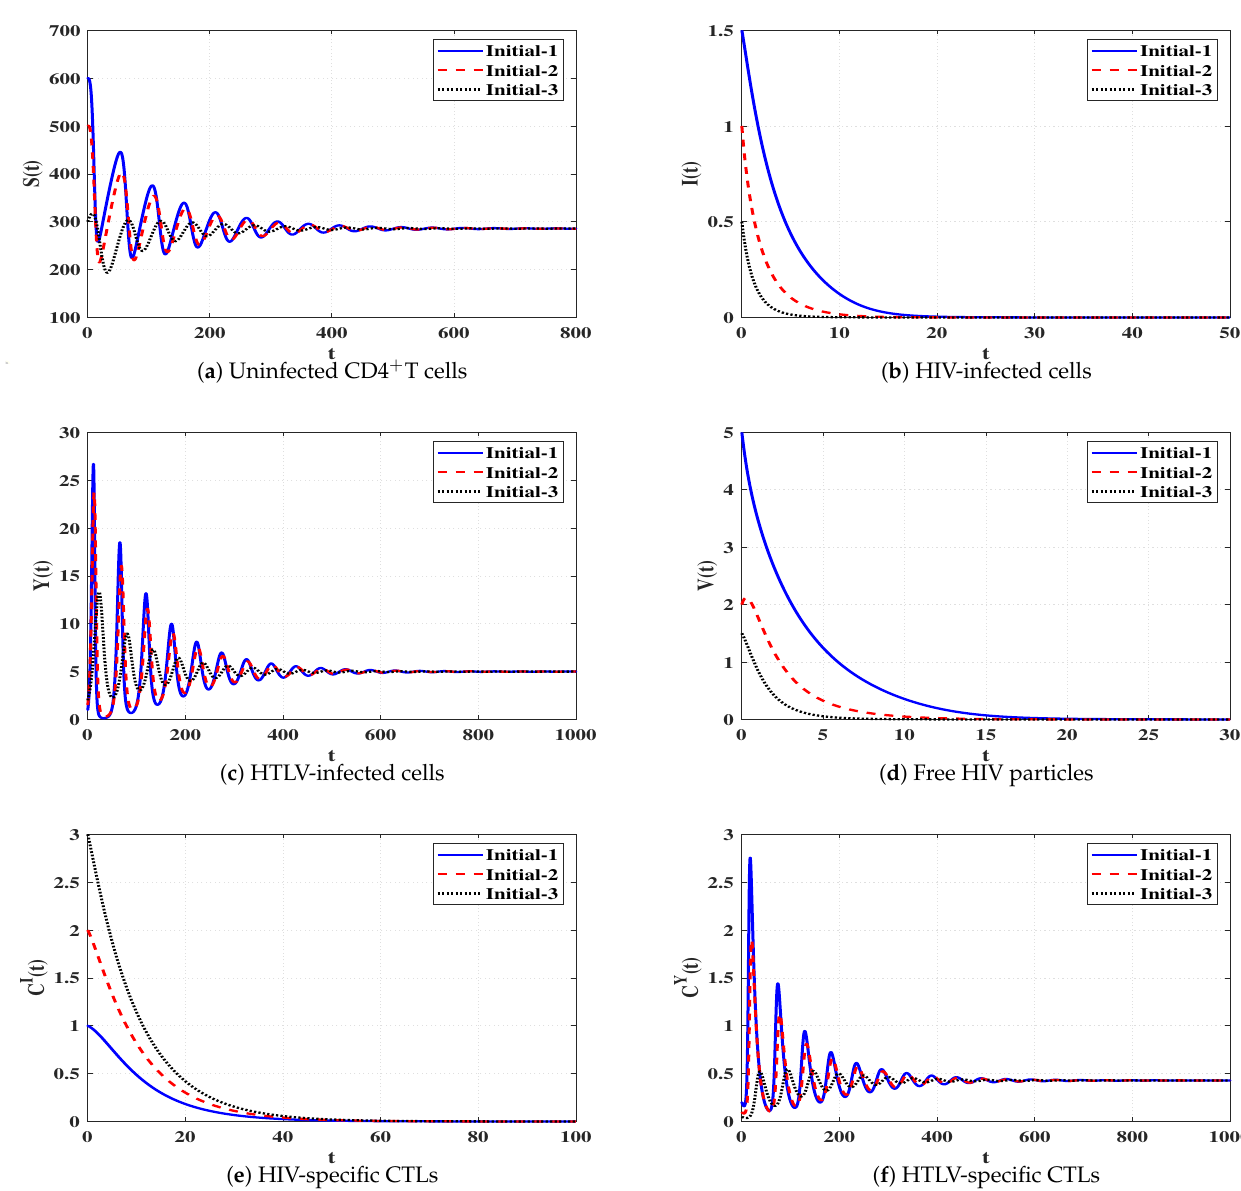
Figure 6. Solutions of system (4) when (cid:60) 4 > 1 and (cid:60) 6 ≤ 1. Set 8 (Stability of Ð 7 ) : η 1 = 0.002, η 2 = 0.0026, σ 1 = 0.04 and σ 2 = 0.1. These data give (cid:60) 7 = 3.98 > 1 and (cid:60) 8 = 1.04 > 1. Based on the data mentioned in Table 1, the steady state Ð 7 = ( 398.48, 2.50, 1, 6.25, 7.46, 0.04 ) exists. Figure 9 illustrates that the solutions of the system initiating with three different states tend to Ð 7 . In this case, a persistent dual infection with HTLV and HIV is reached where both immune responses are well